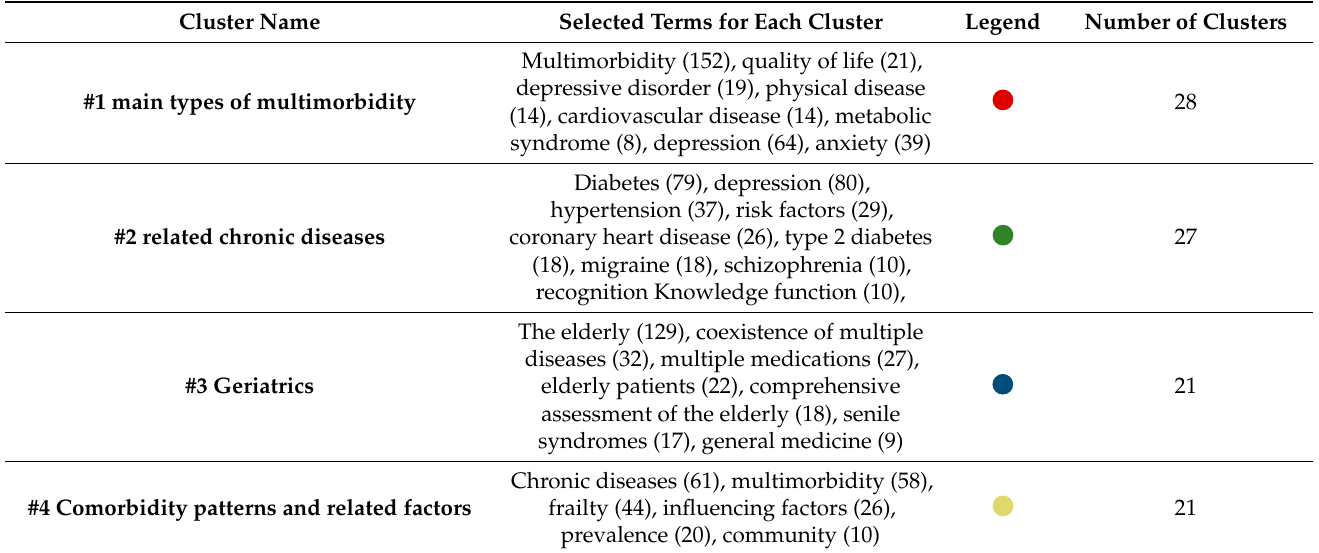
Figure 8. Burst keywords analysis of global high-frequency. In contrast, the top 20 high-frequency keywords in 664 articles in Chinese are sorted into Table 5. Excluded search terms, “Depression” (144 times),” “Diabetes” (79 times), and wake (44 times) were found to be the most three hot words. It was also found that Sun Xirong, Ji Jianlin, Jiang Qi and other author cooperative groups promote depression and diabetes comorbidity research to become a hotspot in this field. Different from other schol- ars around the world, Chinese researchers pay great attention to the quality of life, and disease burden, while studies on risk factors of patients with multimorbidity are similar